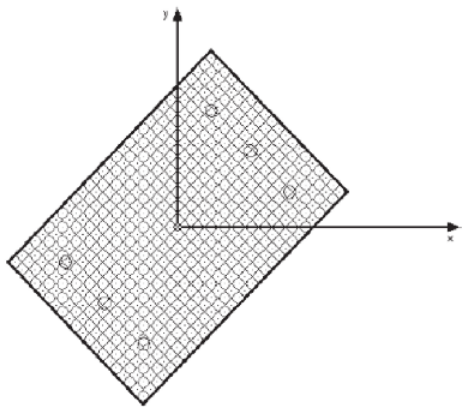
Figura 8 Diagrama tensão-deformação do concreto comprimido à temperatura